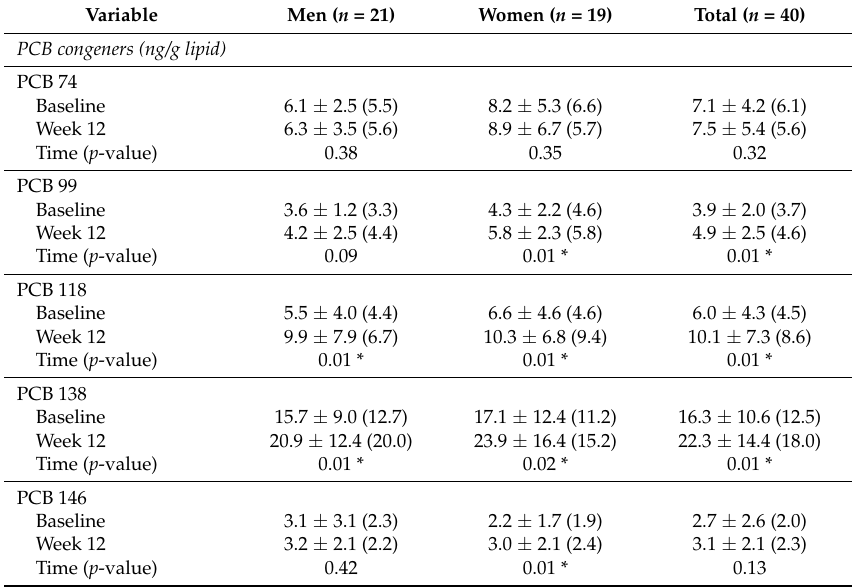
Table 4. Serum PCB congeners and oxidative stress biomarkers following WL (P-CR) intervention (Phase